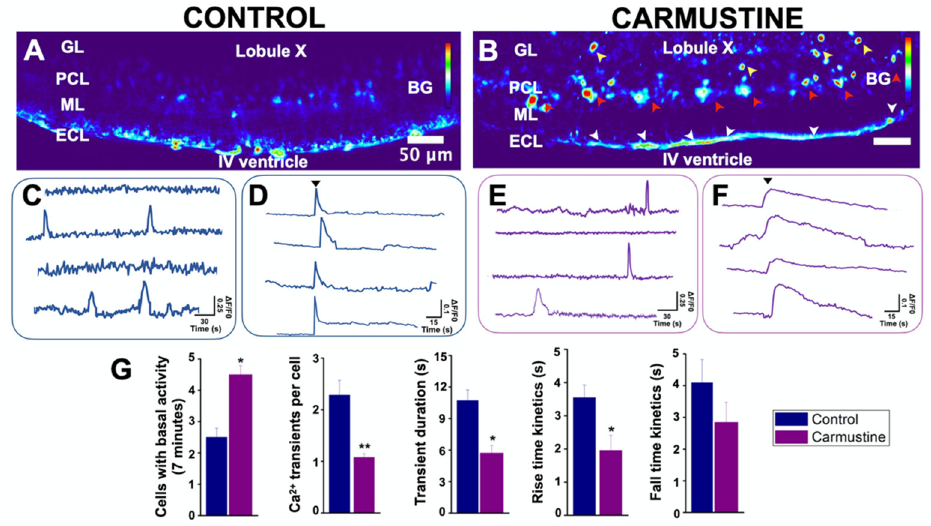
Figure 4. Basal activity of the Bergmann glia is increased in cortical dysplasia. ( A , B ). Heat maps of the maximum projection image of basal activity of the BG from a sample coronal section of the lobule X of the cerebellum of transgenic GFAP-eGFP male mice (P5). ( B ). The image reveals higher activity in the carmustine-treated cerebellum, mainly in BG cells (red arrowheads), astrocytes from the granular layer (yellow arrowheads), and ependymal cells (white arrowheads. ( C , E ). Representative basal (Ca 2+ ) traces of control and carmustine-treated BG cells. More cells were engaged in calcium activity in the carmustine-treated animals. Notice the differences in the activity kinetics. ( D , F ). At the end of the recordings, application of ATP (black arrowhead) increased the (Ca 2+ ) fluorescence (dF/F0) response in all BG. ( G ). Comparative analysis between the control and carmustine-treated groups. BG cells from carmustine-treated mice presented more cells with spontaneous Ca 2+ activity, but with a reduced number of Ca 2+ transient events per cell. BG also exhibited shorter duration and reduced rise-and-fall kinetics time in these events. An average of 83.5 ± 6.11 Bergmann cells responded to ATP in the recorded area of each experimental slice (Control n = 6), whereas 76.25 ± 2.39 Bergmann cells responded to ATP in carmustine-treated slices (Carmustine n = 5 pups, each from a different carmustine-treated mother). Data are represented as the mean ± the standard error of the mean. * indicates significant difference ( p < 0.05) and ** indicates significant difference ( p < 0.001) both compared to the control group. ML: molecular layer, PCL: Purkinje cell layer, GL: granule cell layer, ECL: ependymal cell layer.